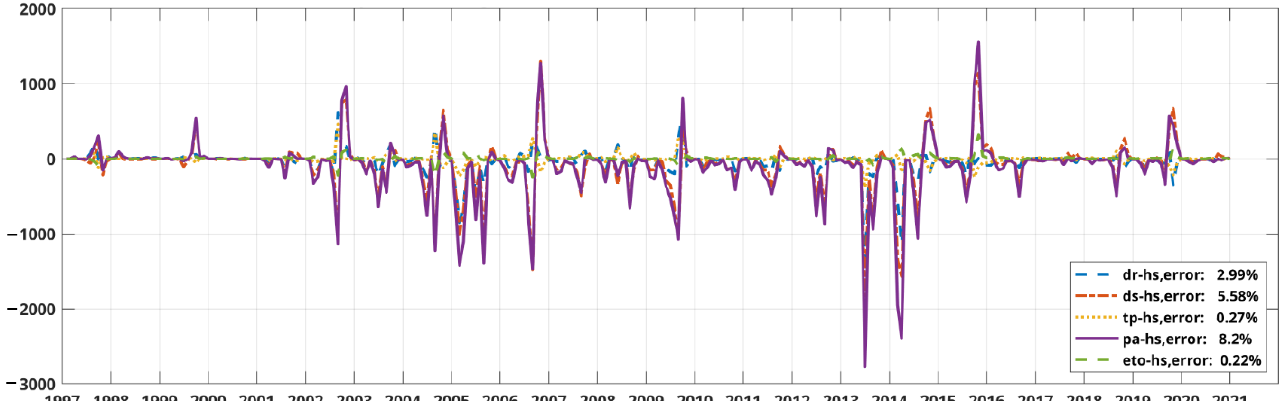
Figure 6. Difference between raw data and joint temporal pattern of hotspots.